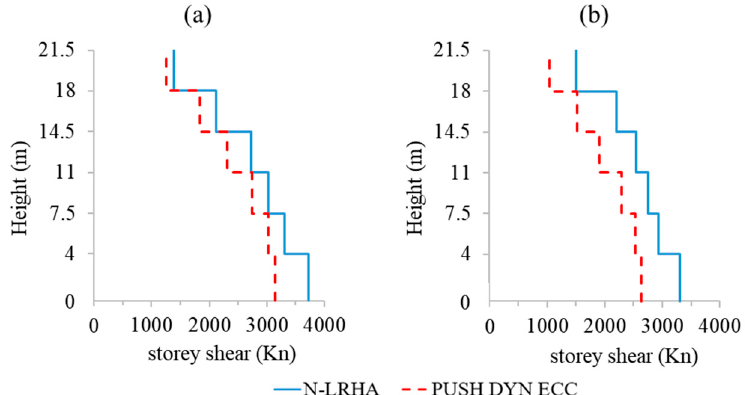
Figure 17. Maximum story shears resulted from the “inelastic dynamic eccentricity” pushover procedure on the case 2 building: ( a ) 𝑉 (cid:2945)(cid:2929)(cid:2915)(cid:2913) along the 𝐼 (cid:2929)(cid:2915)(cid:2913) axis, ( b ) 𝑉 (cid:2945)(cid:2893)(cid:2929)(cid:2915)(cid:2913) along the 𝐼𝐼 (cid:3046)(cid:3032)(cid:3030) axis. Com- procedure on the case 2 building: ( a ) V Isec along the I sec axis, ( b ) V IIsec along the II sec axis. Comparison parison with the seismic demand from N-LRHA. with the seismic demand from